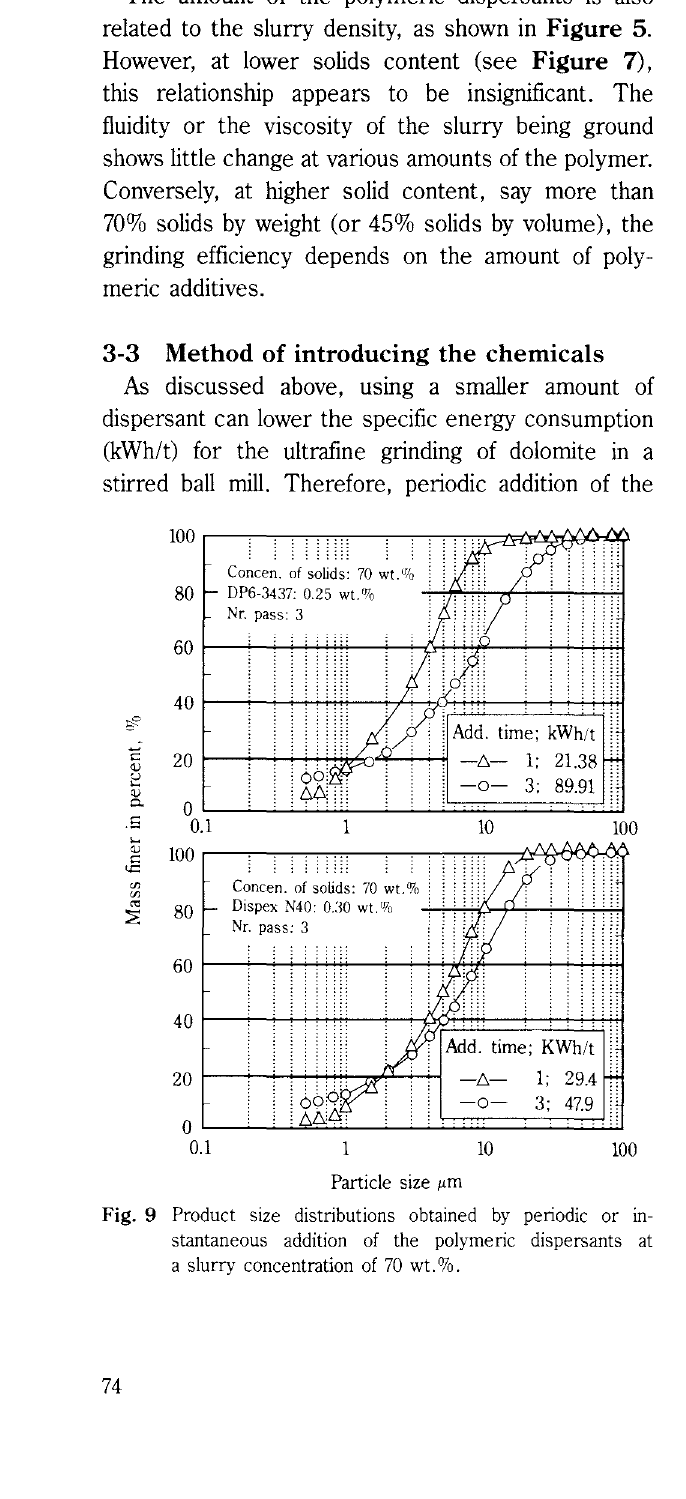
Fig. 9 Product size distributions obtained by periodic or in stantaneous addition of the polymeric dispersants at a slurry concentration of 70 wt.